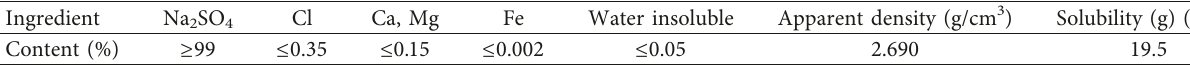
Table 3: Technical indicators of sodium sulfate.